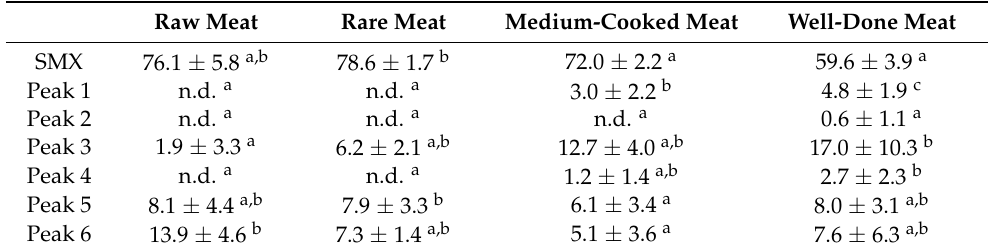
Table 2. Percentage of the radioactivity detected by Radio-HPLC represented by each peak according to cooking level ( n = 3 for each cooking level). Six peaks corresponding to potential degradation products of 14 C-sulfamethoxazole (SMX) were detected in raw and cooked meat